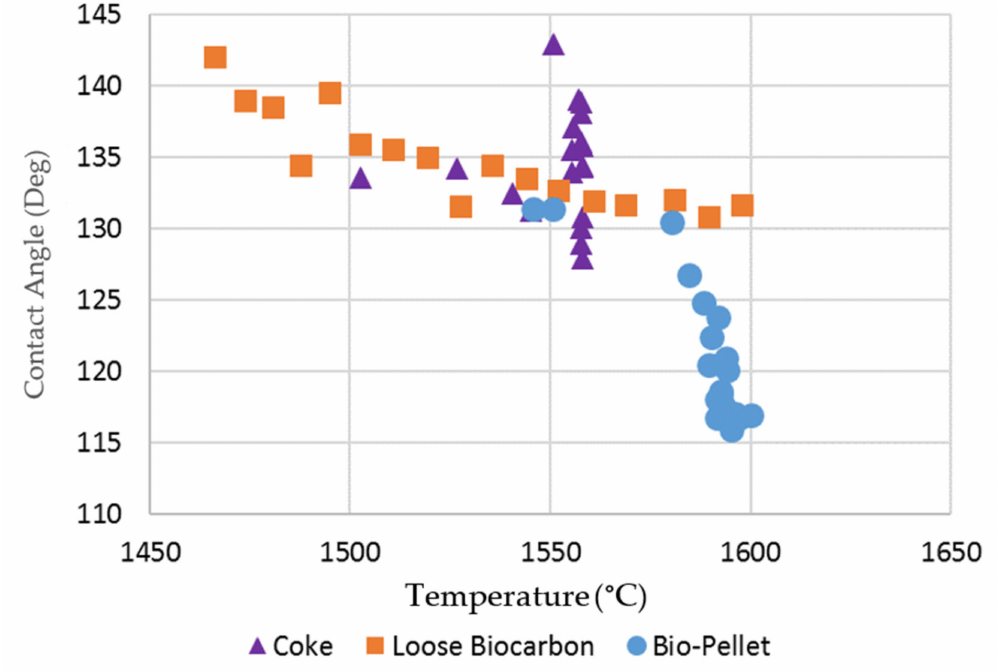
Figure 10. Contact angle of molten slag on coke, loose bio-char (SSBC-1) and densified bio-char (SSB-Pellet)